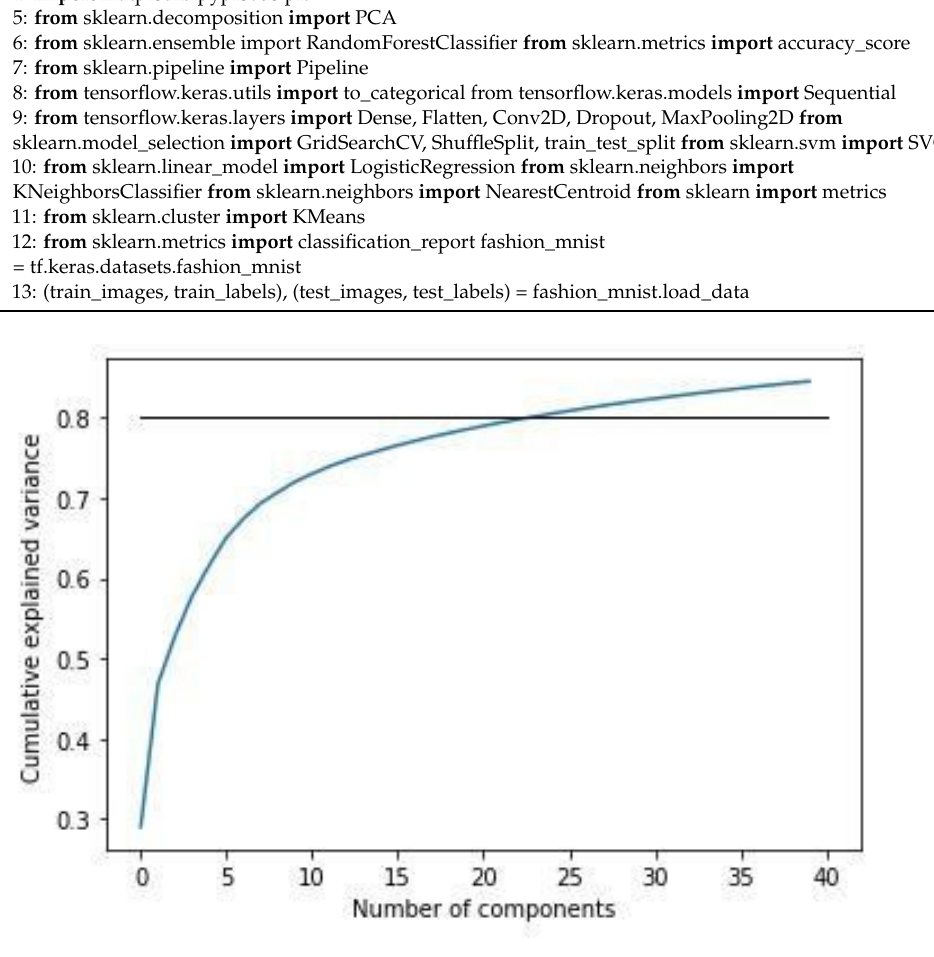
Figure 2. CNN-Components Calculation.